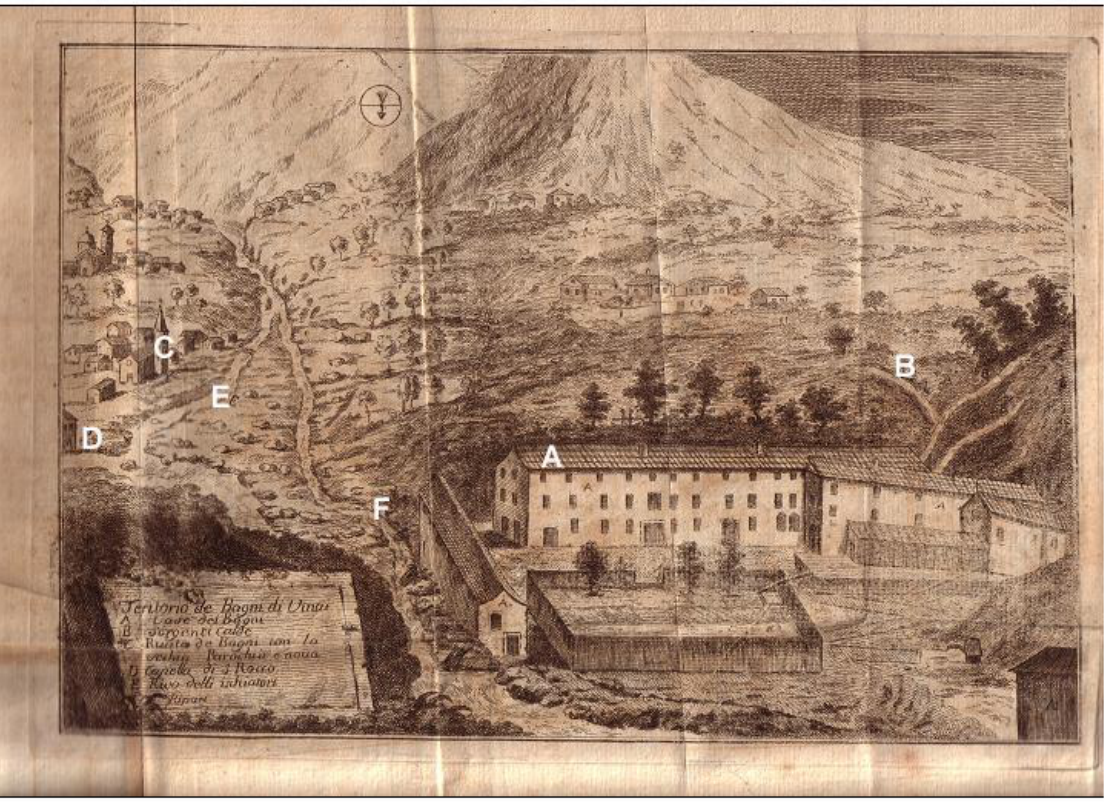
Figure 15. A rare lithograph reproduction dating back 1775 in which the Bagni thermal housing, on the Ischiator alluvial fan, is depicted ( A ), as well as the thermal springs ( B ). Other inscriptions are the old Bagni village ( C ) and the ruins of the San Rocco Chapel ( D ), partly destroyed by debris flow occurring in 1754 by the Ischiator torrent ( E ). Defense structures ( F ) are also depicted.